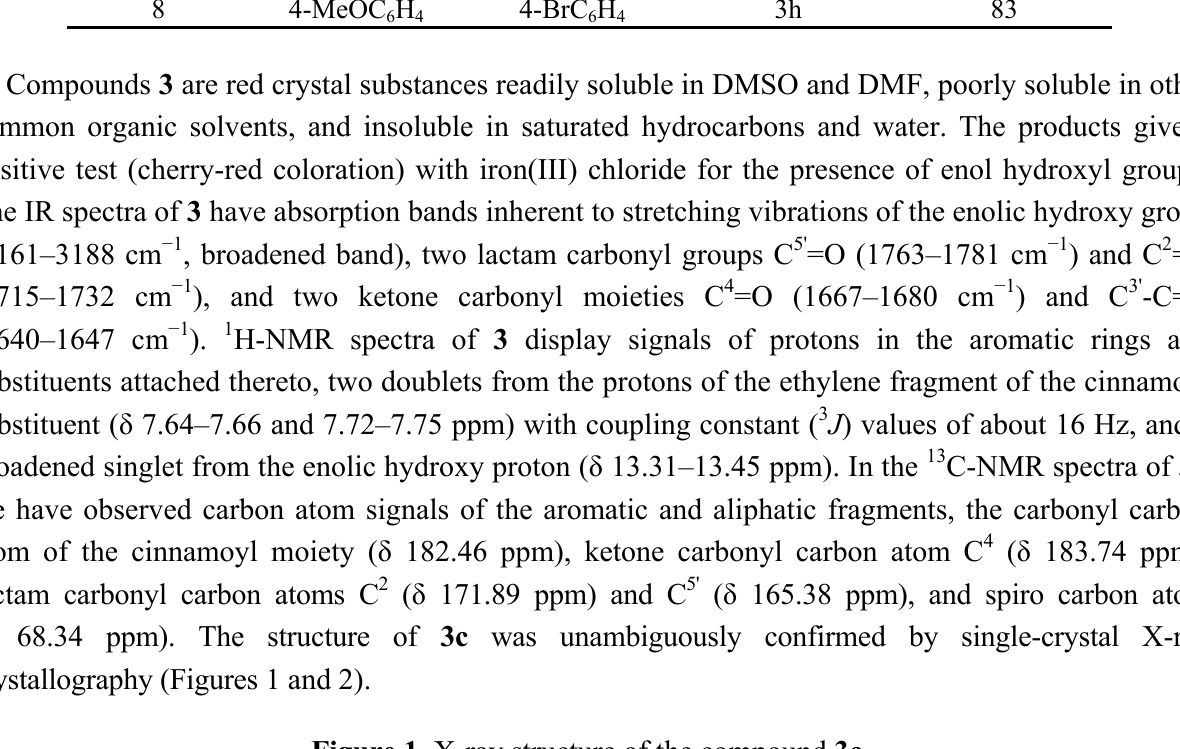
Figure 1. X-ray structure of the compound 3c